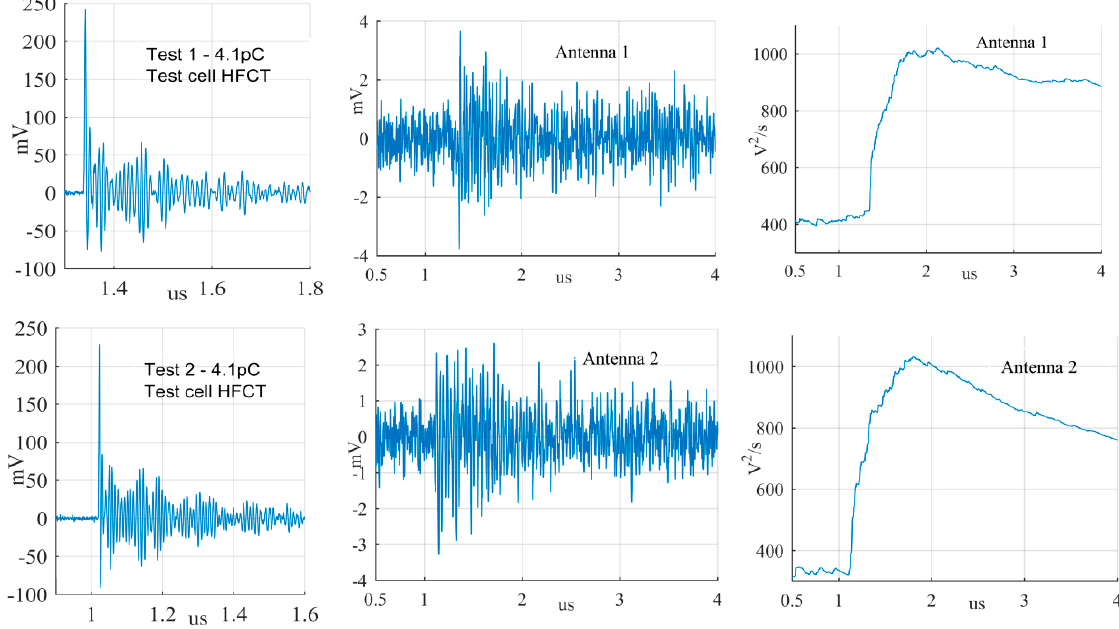
Figure 13. Largest surface discharge from the antenna at position 1 and 2.